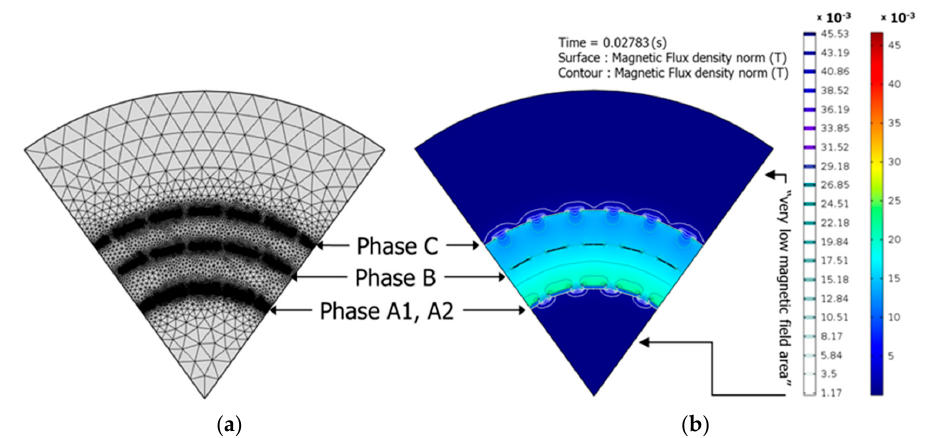
Figure 4. Configuration of the FEM model for loss analysis: ( a ) the mesh mode used for calculations; ( b ) the calculated magnetic field distribution.